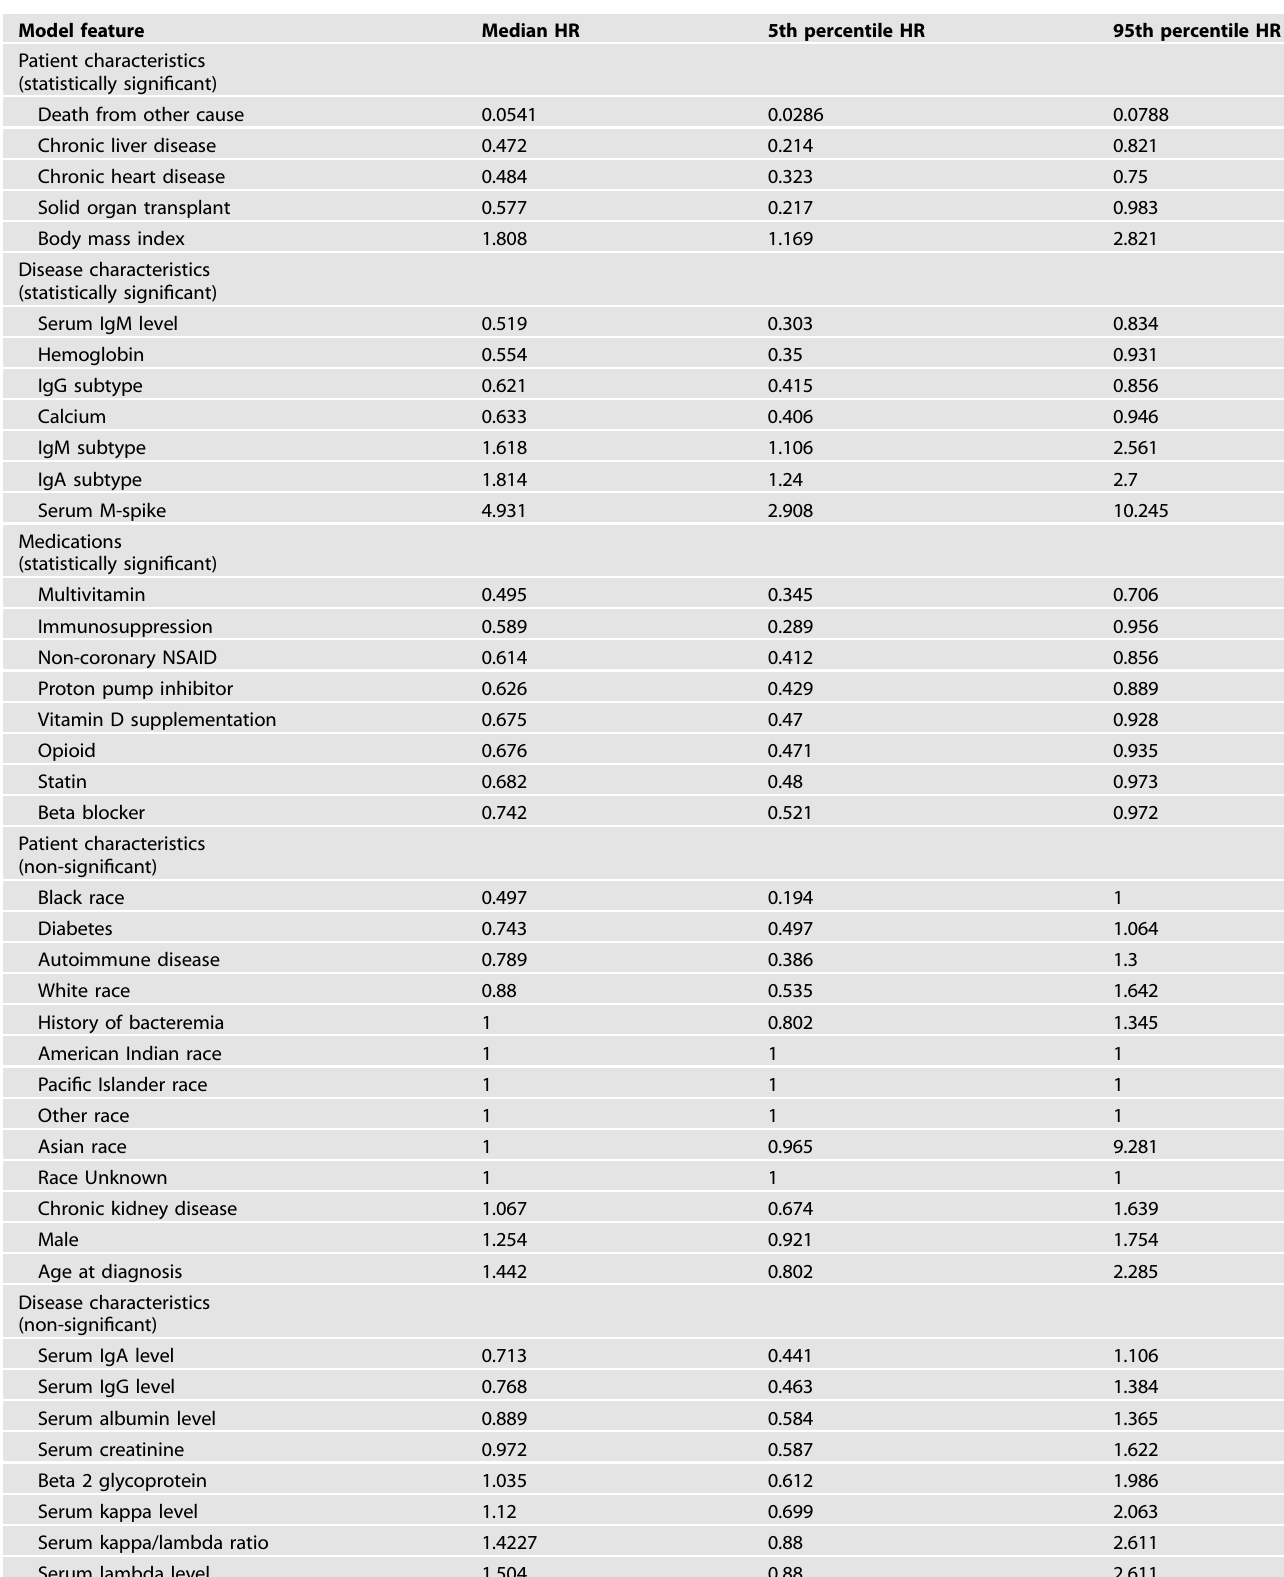
Table 3. Model features and associated hazard ratios with con fi dence